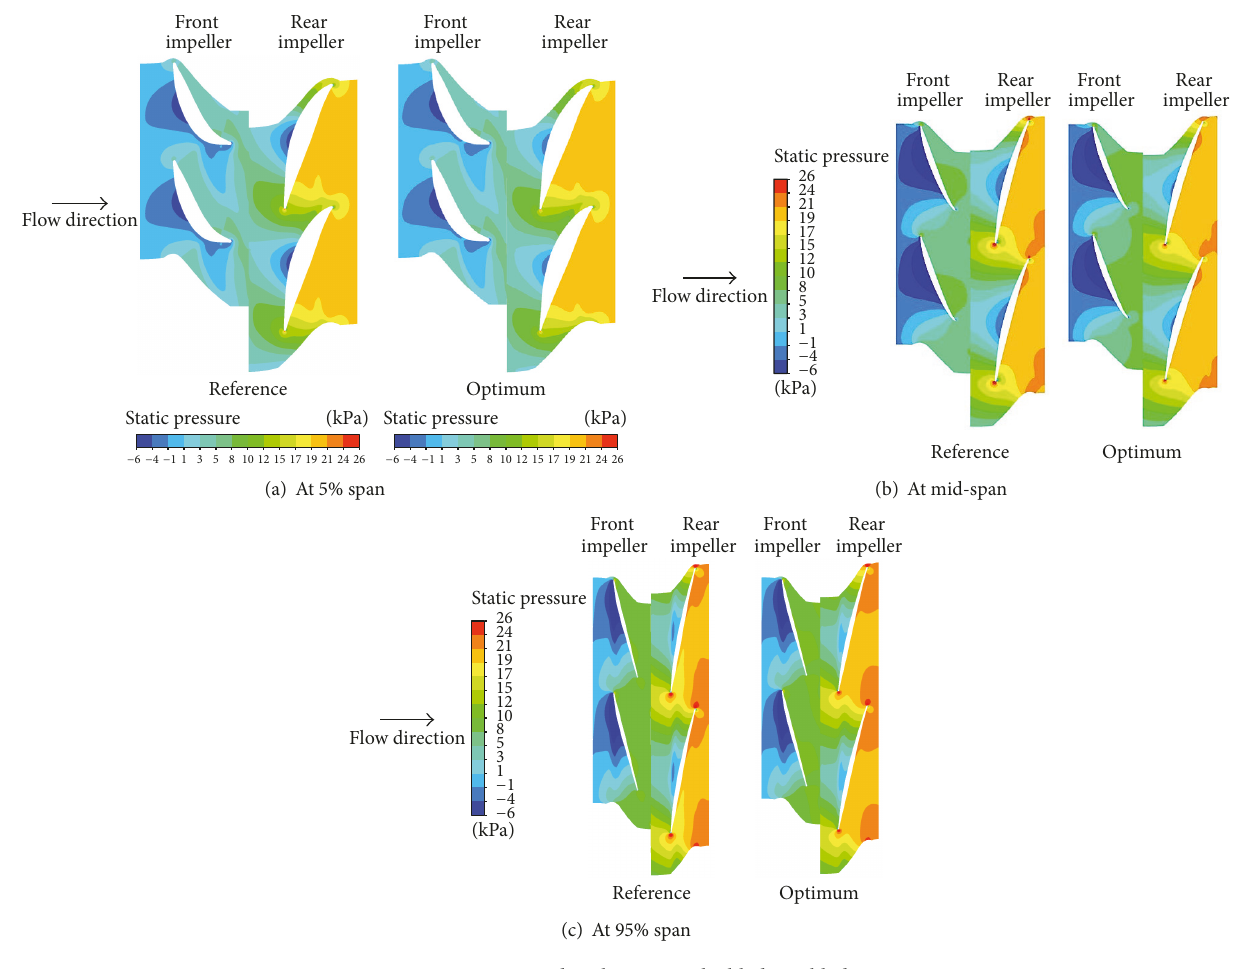
Figure 10: Static-pressure distribution on the blade-to-blade passage.